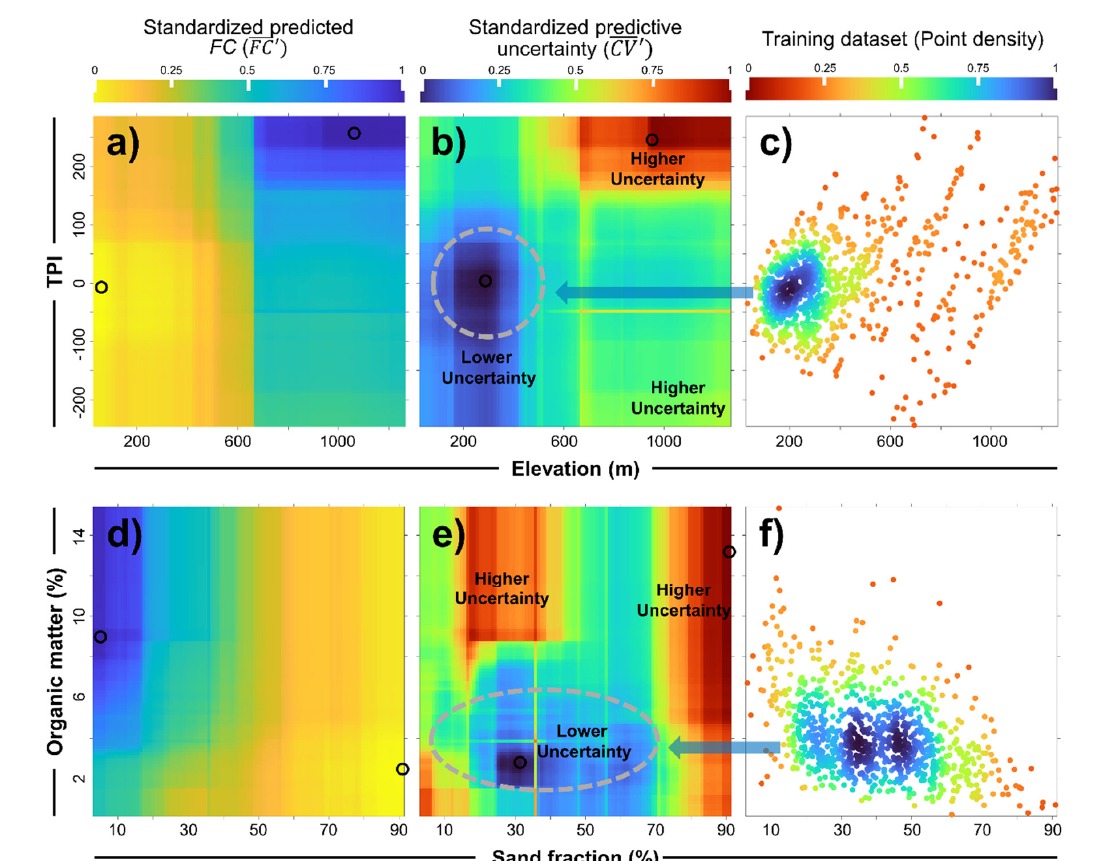
Figure 7. A 2D heatmap of ( a , d ) predicted FCs and ( b , e ) predictive uncertainties, which are the standardized mean values of the CV, and ( c , f ) scatterplot of the training set. The distribution of the predicted uncertainties is not related to the predicted FCs but is strongly related to the distribution of the training set.